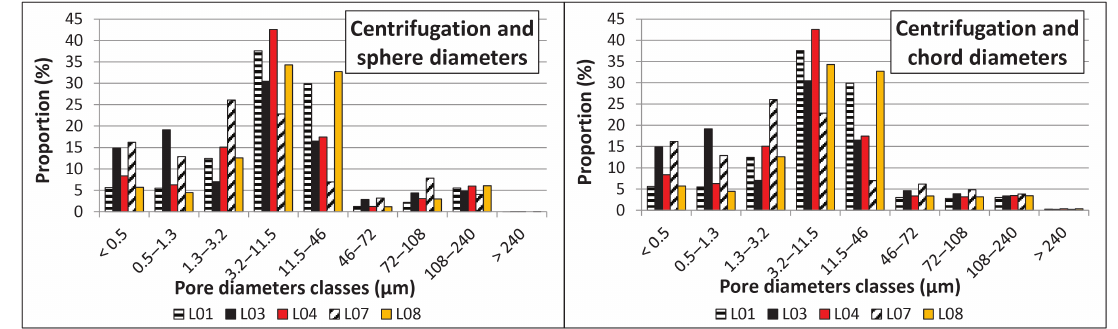
Figure 11. Pore diameters distributions from laboratory and XRMT calculations for Lexos rock type. Distribution from centrifugation and sphere diameters analysis is displayed on the left, while distribution from centrifugation and chord lengths analyses is shown on the